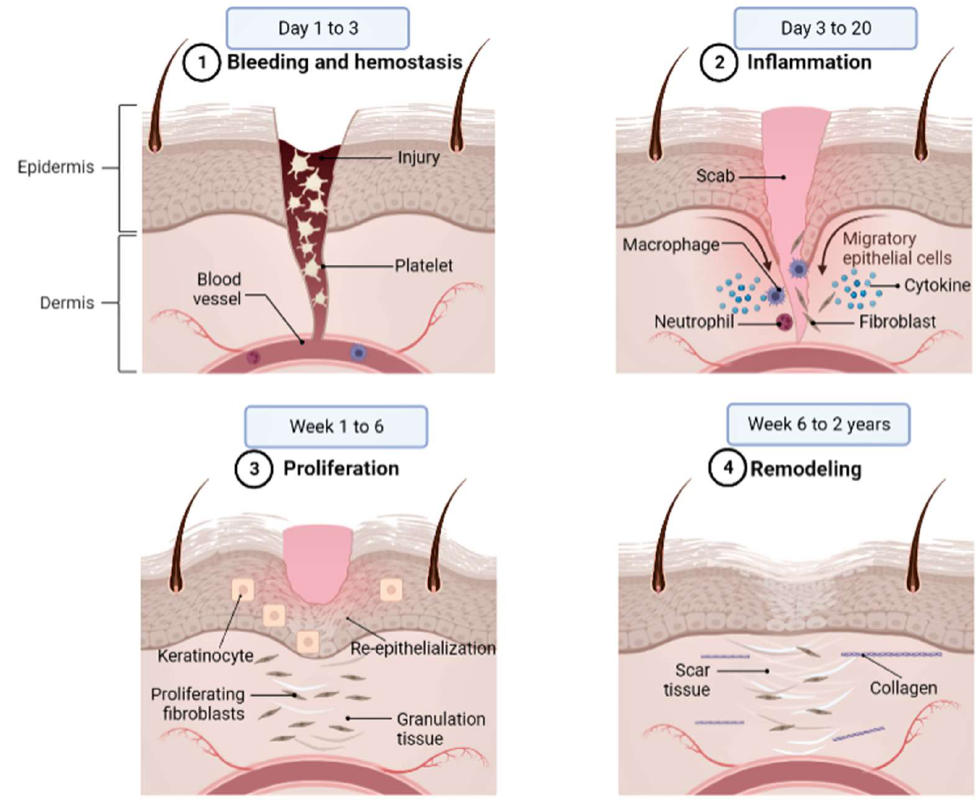
Figure 1. Physiological wound-healing phases. ➀ Bleeding and hemostasis: hemostasis occurs im- mediately after bleeding and reduces blood flow by constricting blood vessels to stop bleeding fol- lowing vascular injury. ➁ Inflammation: the release of cytokines, growth factors, and the migration of leukocytes into the area cause hemostasis and acute inflammation in the area of a wound. ➂ Proliferation: an increase in the keratinocyte, fibroblast, endothelial, and leukocyte migration and proliferation in the wound area. ➃ Remodeling: the process in which stretching and pulling forces interact with the scar tissue. They help collagen to regain the normal alignment that is needed.